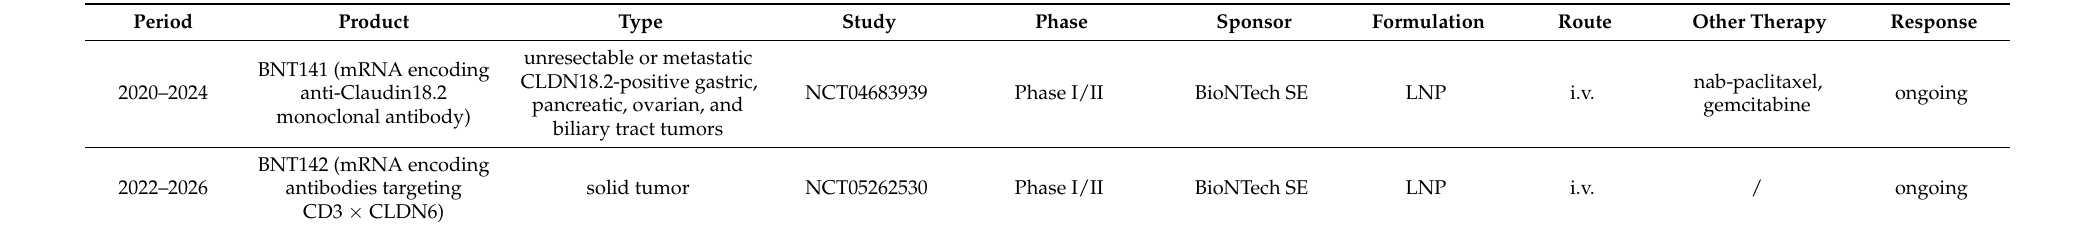
Table 5. Clinical trials of mRNA encoding